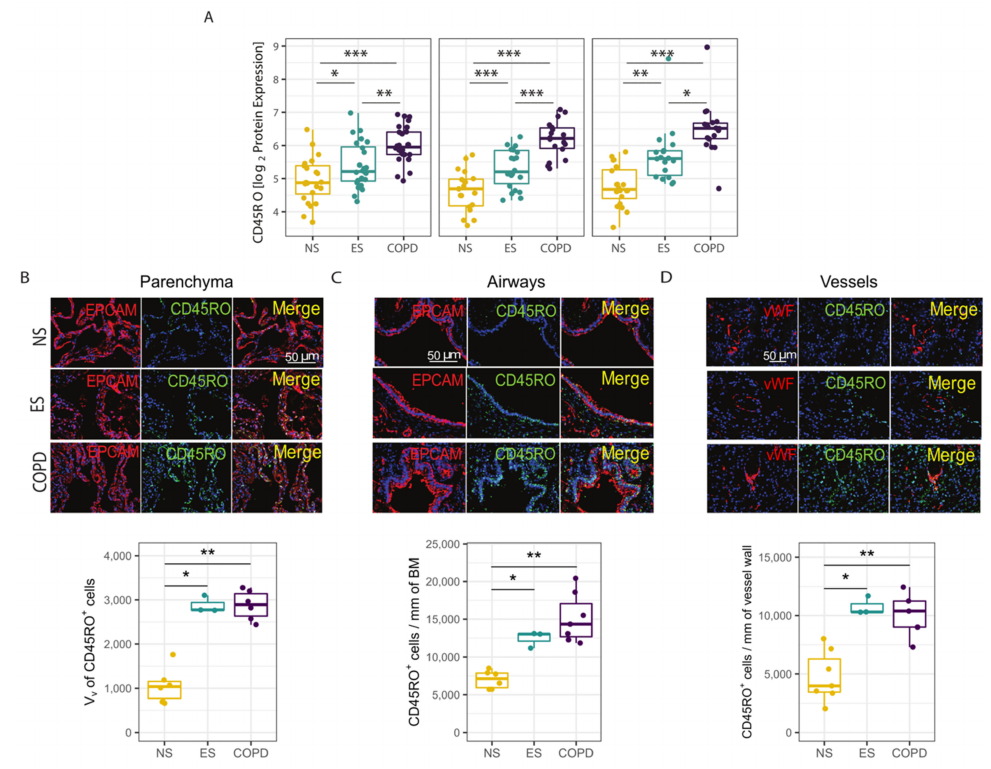
Figure 5. CD45RO spatial protein expression. ( A ) CD45RO protein expression levels were quantified in the parenchyma, airway, and vessel ROIs in formalin-fixed paraffin-embedded (FFPE) lung tissue sections from patients with COPD versus ever- (ES) and never-smoker (NS) controls by NanoString GeoMX digital spatial profiling. The data were assessed using generalized estimating equations (GEEs) accounting for multiple ROIs per case and were adjusted for age. The box plots represent the median and interquartile range, the error bars indicate the 5th and 95th percentile, and each dot represents a single ROI. ( B – D ) CD45RO + cells were quantified in the parenchyma ( B ), airways ( C ), and vessels ( D ) in patients with COPD vs. ever- (ES) and never-smoker (NS) controls by double immunofluorescence staining for CD45RO (green) and epithelial (pan-cytokeratin, red) or endothelial cells (von Willebrand factor, red). The non-normally distributed data were assessed using Kruskal– Wallis and Mann–Whitney tests, the box plots represent the median and interquartile range, the error bars indicate the 5th and 95th percentile, and each dot represents a single subject. *: p < 0.05; **: p < 0.01; ***: p <